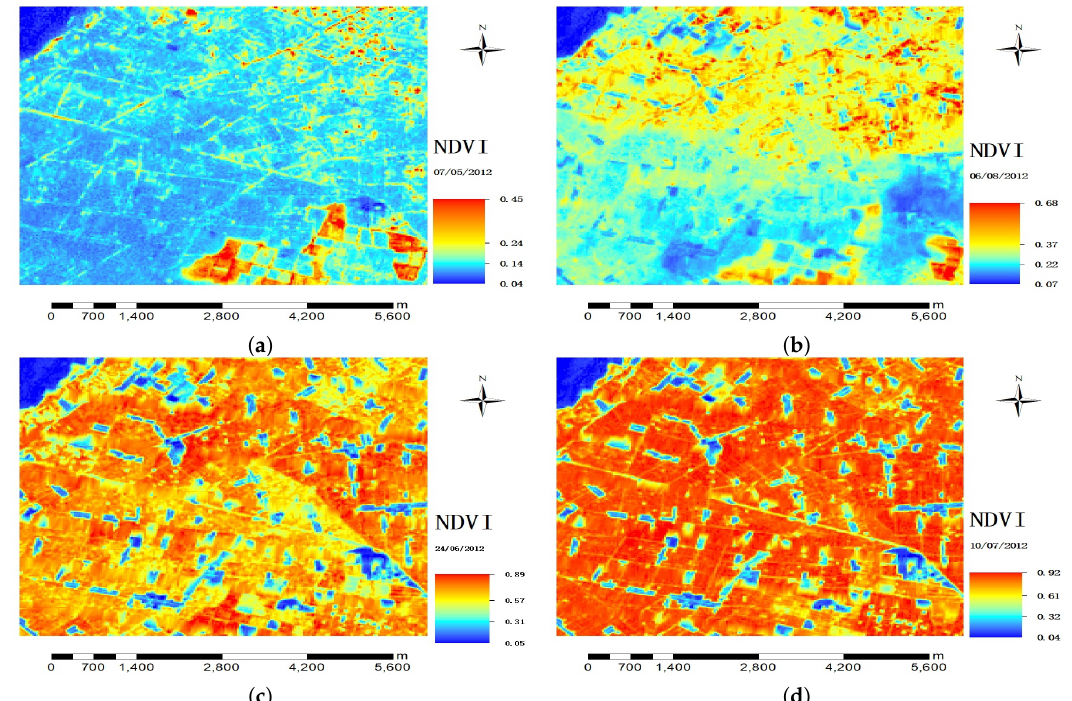
Figure 3. The NDVI maps for four days. ( a ) NDVI map on 7 May; ( b ) NDVI map on 8 June; ( c ) NDVI map on 24 June; ( d ) NDVI map on on 10